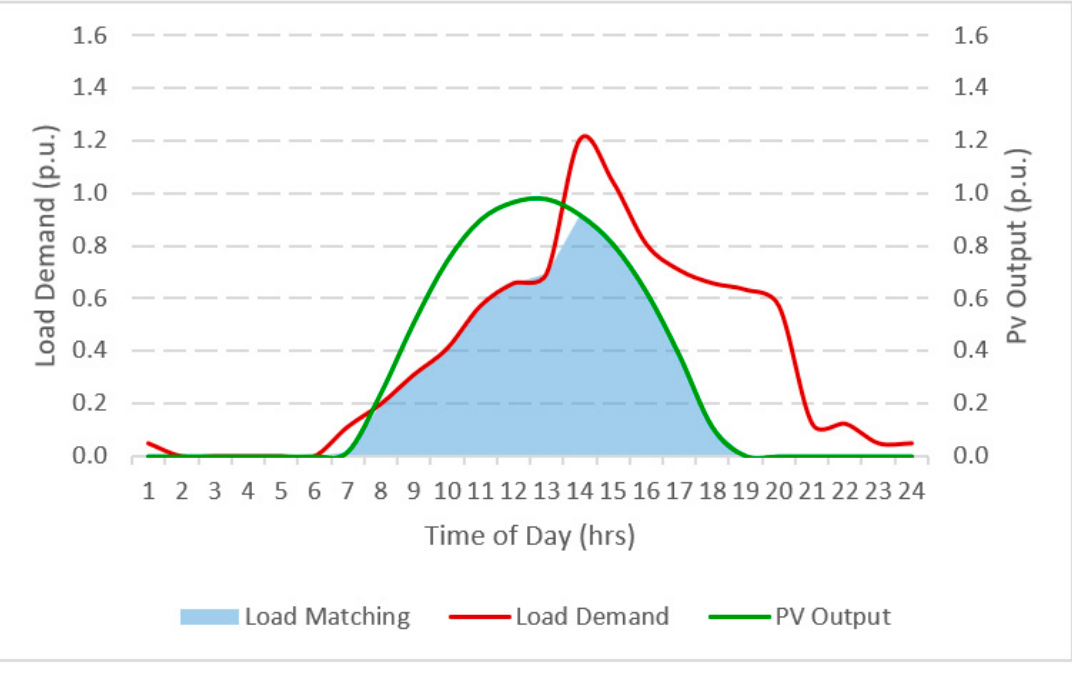
Figure 13. Load matching in 2025.